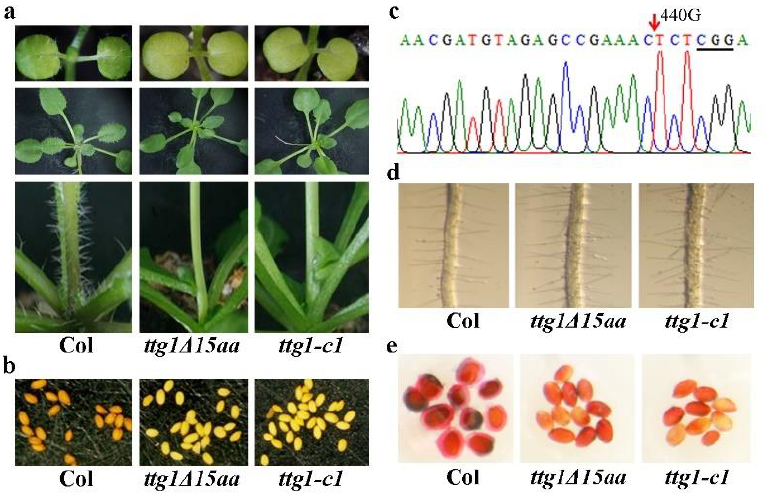
Figure 1. Phenotypes of the ttg1 ∆ 15aa mutant and a TTG1 gene-edited mutant. ( a ) Trichome formation on leaves of 10-day-old seedlings (up panel), 4-week-old plants (middle panel), and stems of 5-week-old plants (lower panel) of the Col wild type, the ttg1 ∆ 15aa , and the ttg1-c1 mutants. Seeds of the Col wild type, the ttg1 ∆ 15aa , and the ttg1-c1 mutants were germinated and grown in soil pots. Pictures were taken directly or under a Motic K microscope by using an EOS 1100D digital camera at indicated stages. ( b ) Seed color of the Col wild type, the ttg1 ∆ 15aa and the ttg1-c1 mutants. Pictures were taken under a Motic K microscope by using an EOS 1100D digital camera. ( c ) Editing status of TTG1 in the ttg1-c1 mutant. The arrow indicates the 440 G deletion in the ttg1-c1 mutant. Underline indicates the PAM site. The mutant was obtained by transforming the Col wild type plants with the pHDE-TTG1 CRISPR/Cas9 construct. Editing status of TTG1 was examined in T1 plants, and Cas9-free homozygous mutant plants were obtained in T2 generation. ( d ) Root hair formation in the Col wild type, the ttg1 ∆ 15aa , and the ttg1-c1 mutants. Seeds of Col wild type, the ttg1 ∆ 15aa , and the ttg1-c1 mutants were germinated and grown on half MS plates vertically. Pictures were taken from 7-day-old seedlings under a Motic K microscope by using an EOS 1100D digital camera. ( e ) Mucilage production in the Col wild type, the ttg1 ∆ 15aa , and the ttg1-c1 mutants. Seeds were stained with 0.01% ( w/v ) Ruthenium red for 2 h, and pictures were taken under a Motic K microscope by using an EOS 1100D digital camera.